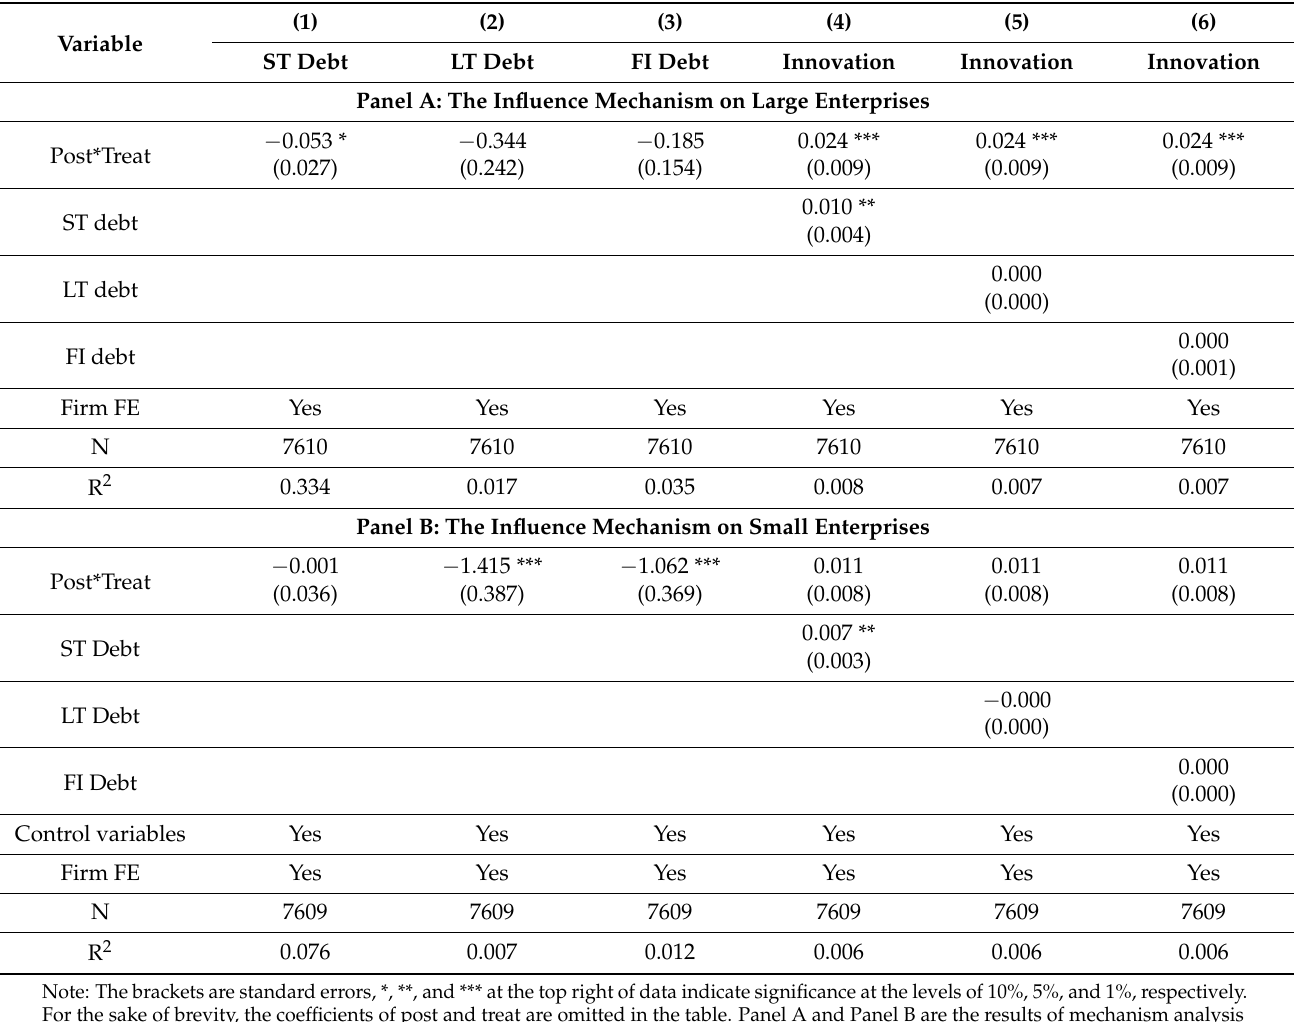
Table 10. Analysis on the influence mechanism in large enterprises and small enterprises.